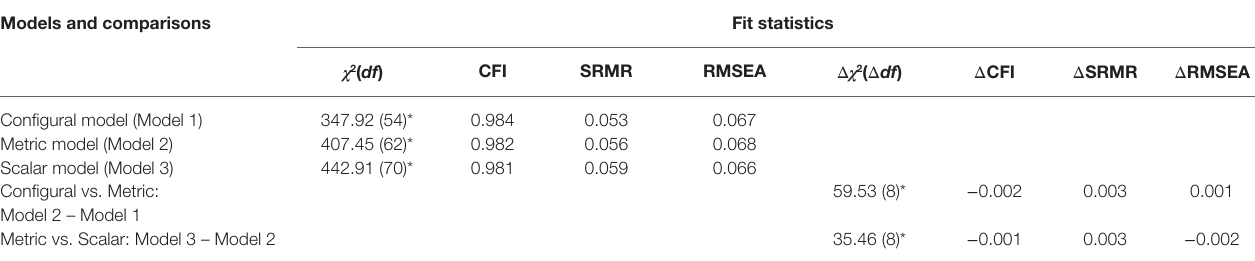
TABLE 3 | Measurement invariance across gender through multigroup confirmatory factor analysis (MG CFA). Models and